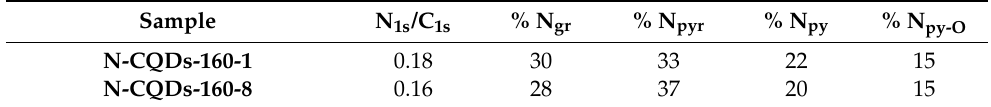
Table 1. XPS peak intensity ratio N 1s /C 1s and relative percentages of graphitic, pyrrolic, pyridinic and pyridine N-oxide (% N gr , % N pyr , % N py , % N py-O , respectively). Sample N 1s /C 1s % N gr % N pyr % N py % N py-O N-CQDs-160-1 0.18 30 33 22 15 N-CQDs-160-8 0.16 28 37 20